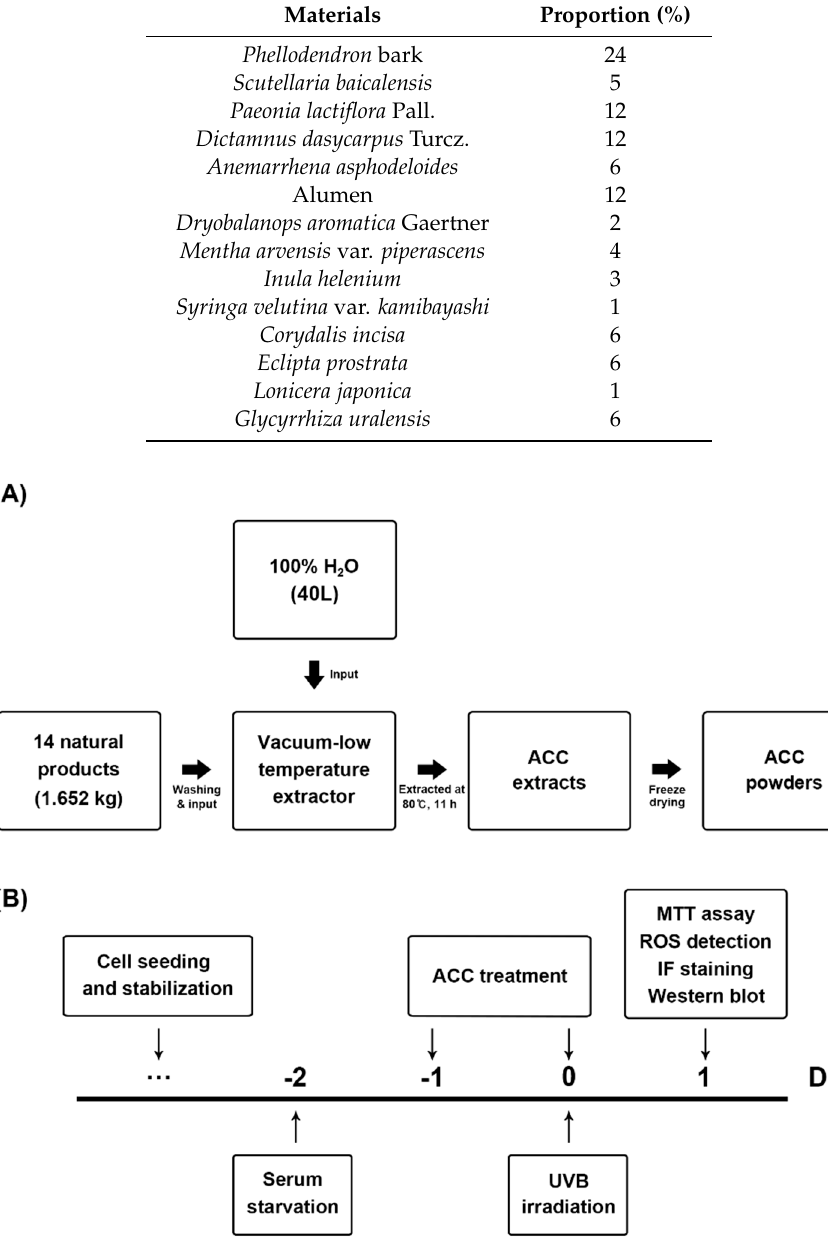
Table 1. Materials and proportion in ACC extracts.